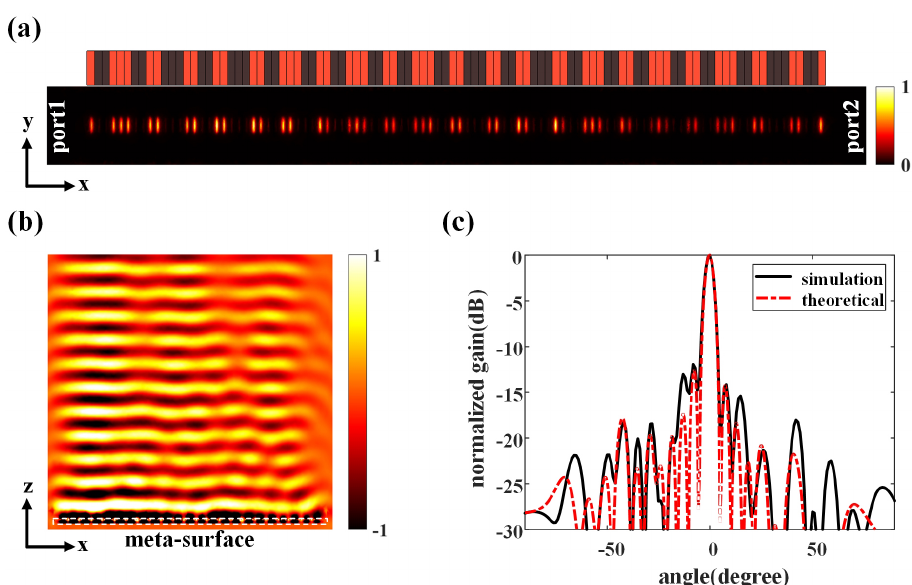
Figure 3. Full wave simulation of the graphene-biased terahertz coding meta-surface at 2.2 THz. ( a ) E-field distributes on the structure of the meta-slot array. The normalized radiating amplitude of the meta-slot is the x -component of electric field at 2.5 µ m above the center of each meta-slot. ( b ) Electric field leakage from the proposed design. ( c ) Normalized radiation patterns.